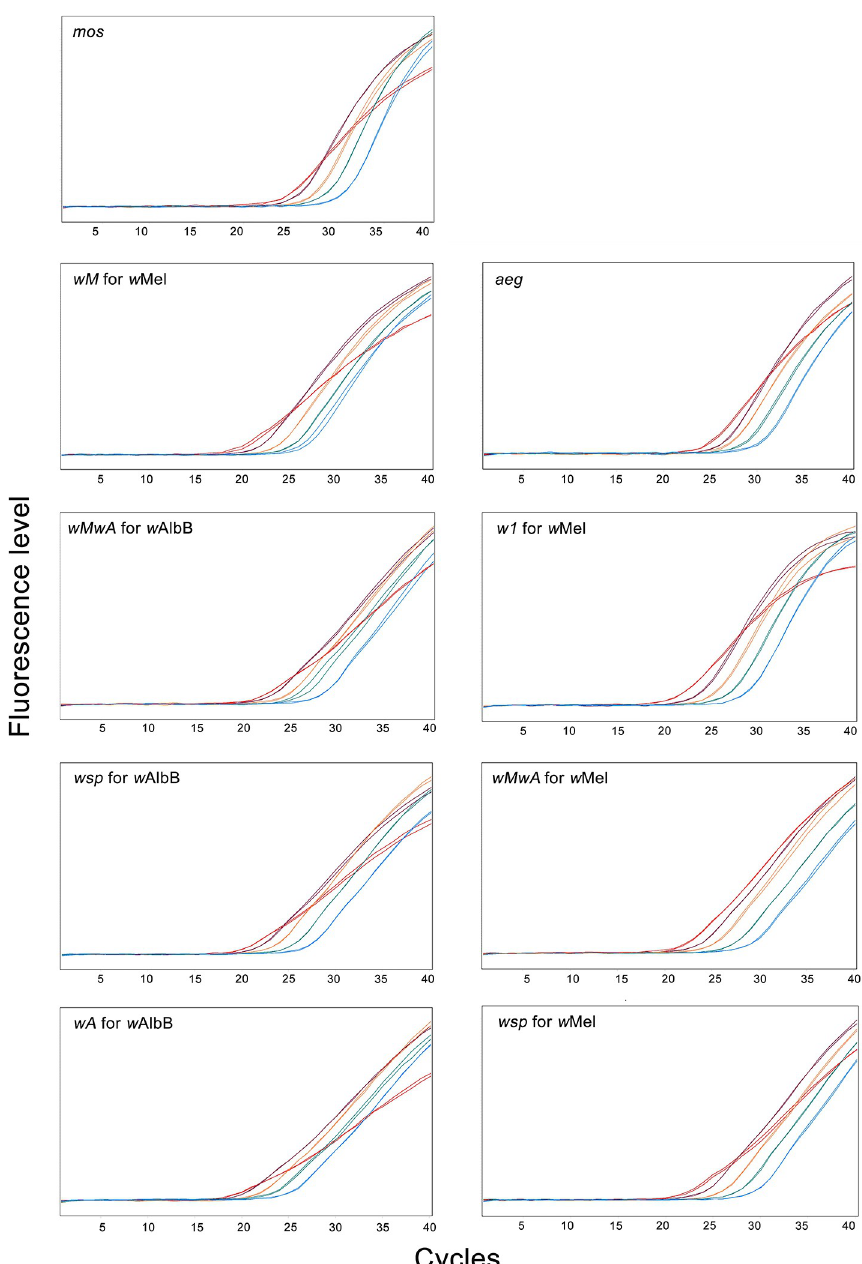
Fig 3. Variation in the shape of the PCR amplification curves. The curves from left to right represent amplification curves of 1/10, 1/30, 1/90, 1/270 and 1/810 DNA dilution from initial extraction in 250 μ L 5% Chelex 1 100 Resin. The primers are defined in Table